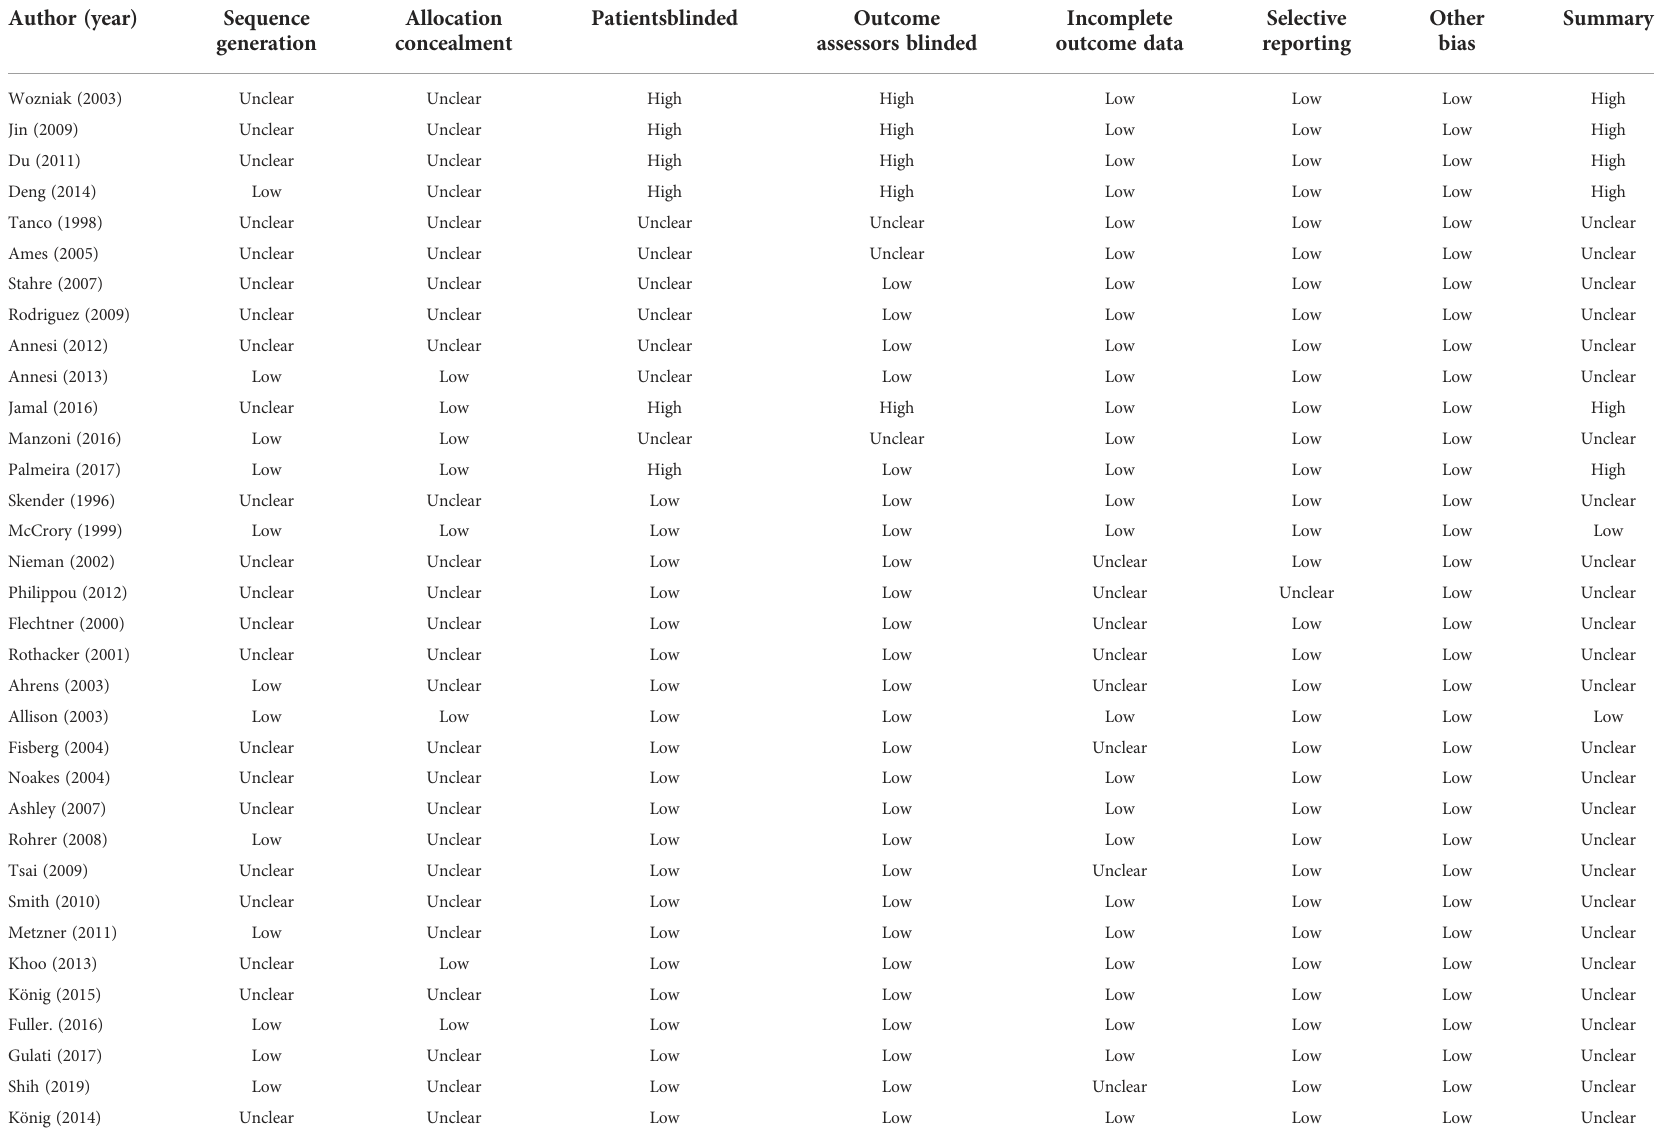
TABLE 5 Risk of bias of within individual